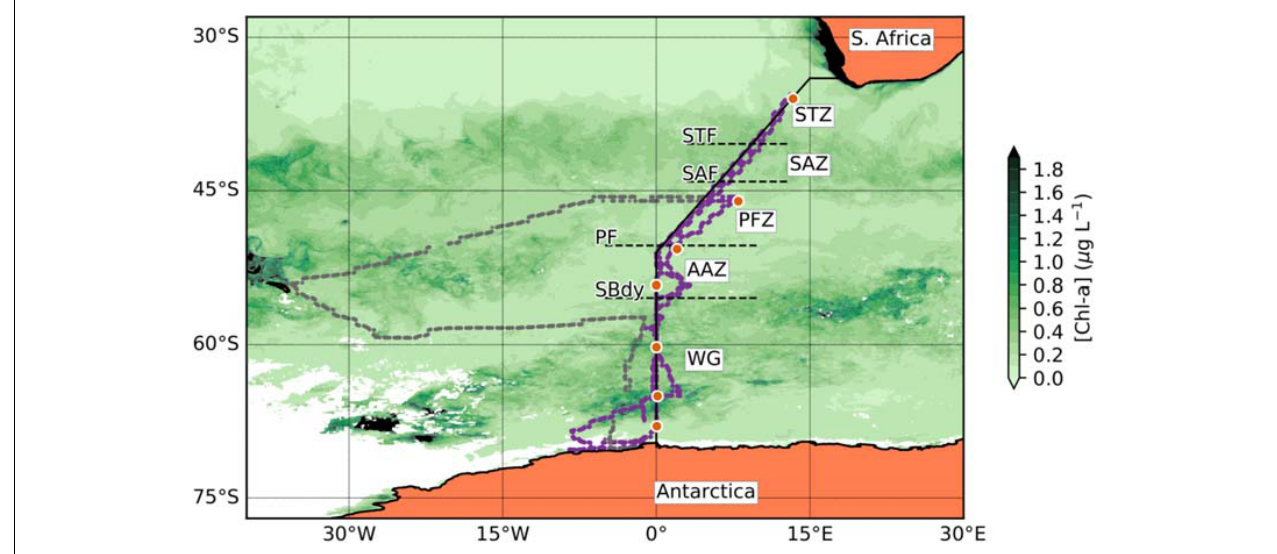
FIGURE 1 | Station positions along the Good Hope line for the SANAE54 cruise. The orange dot symbols indicate the trace metal stations ( Table 1 ). The solid black line represents the Good Hope line. The smaller dots show the actual ship transects during the cruise, purple representing the Good Hope line transect and gray the South Georgia leg. The background shows a seasonal composite of chla concentration for the period of December 2014 to February 2015 (NASA Ocean Biology Processing Group, 2014). The dashed horizontal lines indicate the frontal positions [subtropical front (STF); subantarctic front (SAF); polar front (PF)] and the Southern Boundary (SBdy) of the ACC along the Good Hope line. Black regions on the map represent areas where the chla concentration is higher than 2 µ g L - l whereas white regions indicate insufficient chla data due to ice or cloud cover.